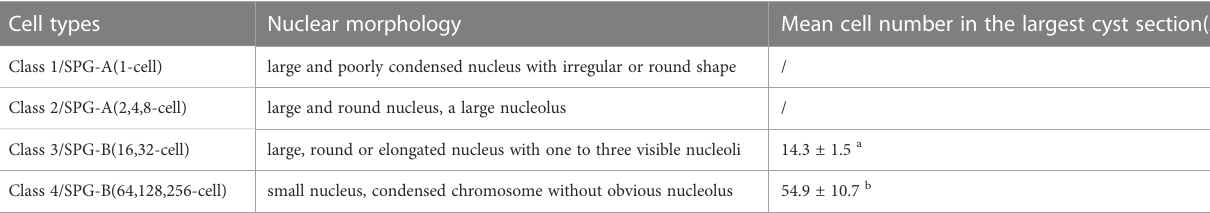
TABLE 2 Identi fi cation of four classes of SPG in zebra fi sh using morphological